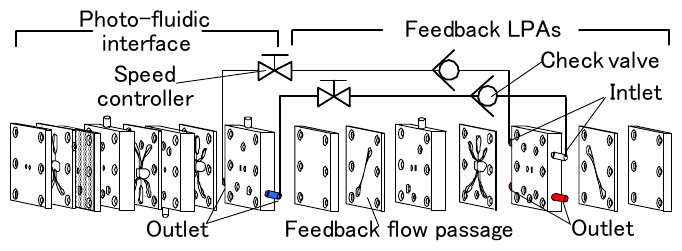
Fig. 10 Construction of improved optical on/off device